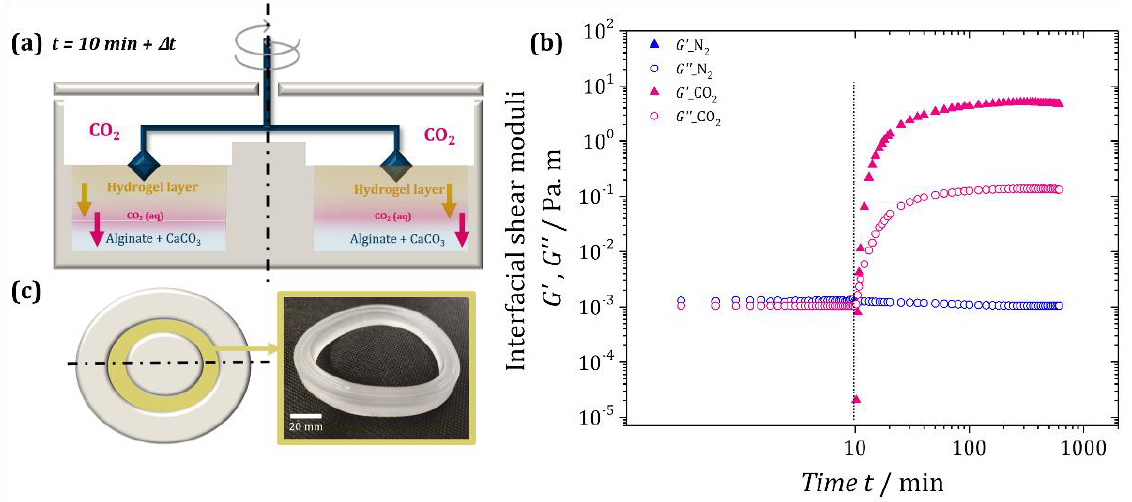
Figure 4. ( a ) Scheme of the double-wall ring (DWR) geometry used for the interfacial shear rheology, showing our understanding of what happens in the presence of CO 2 : The blue layer at the bottom represents the un-gelled solution (1 wt% alginate, 0.02 M CaCO 3 ). The progressing front of dissolved CO 2 (i.e., acidification) is shown in pink, and the progressing gelation front on top in yellow. ( b ) Temporal evolution of the interfacial elastic shear modulus, G ′ , and loss modulus, G ″ , of the gas/liquid surface of the alginate solution when a gas flow of N 2 (blue) or CO 2 (pink) is switched on after 10 min of exposure to ambient air (vertical line). ( c ) Hydrogel sample extracted after the experiment using CO 2 in the form of a ring maintaining the shape of the geometry.